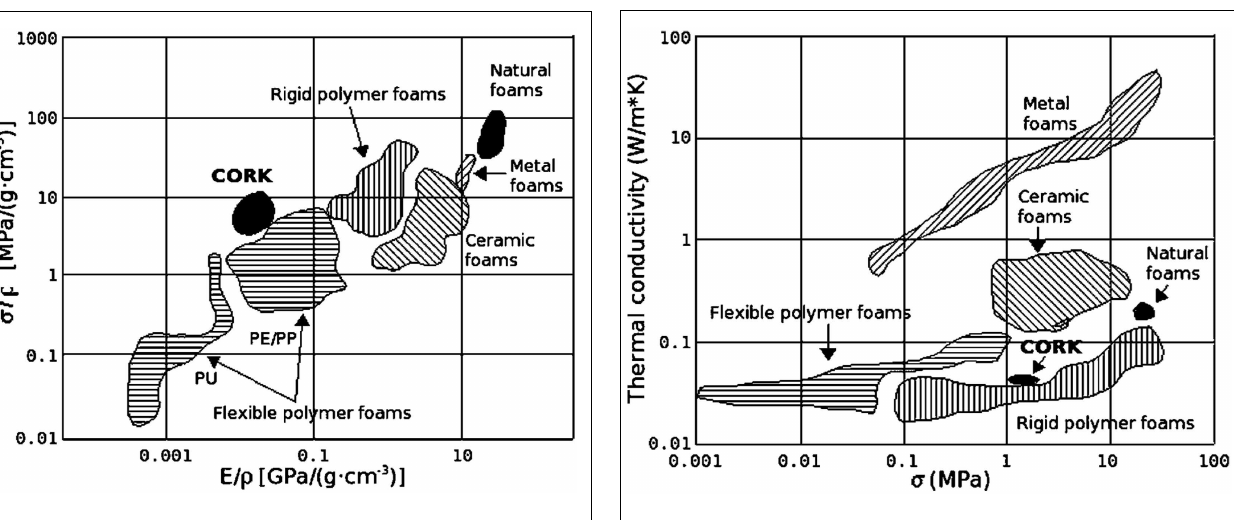
FIGURE 3 | Comparison between thermal conductivity and compressive strength ( σ ) for cork and different foamed materials (Silva et al., 2005)